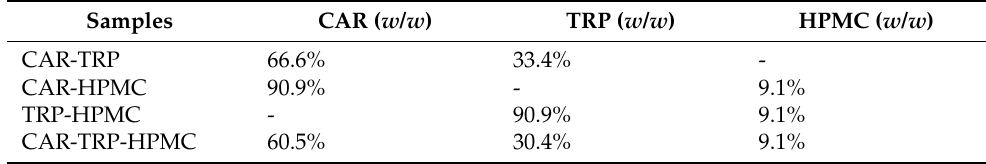
Table 3. Weight ratios of the binary and ternary co-amorphous reference systems for the FT-IR study. Samples CAR ( w / w ) TRP ( w / w ) HPMC ( w / w )